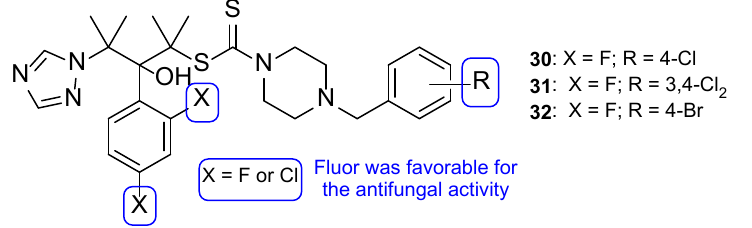
Figure 19. Chemical structures for compounds 30 – 32 and SAR for the phenyl ring [99]. In 2014, Wu et al. designed and synthesized a series of new fluconazole analogs, utilizing a thiazolidinedione scaffold instead of one of its triazole rings. The antifungal effects of the compounds were assessed using the broth microdilution method as values of MIC 80 and fluconazole was used as standard. Compounds 33 – 35 (Figure 20) presented good inhibitory activity against all tested strains ( C. albicans , C. parapsilosis , C. neoformans , C. glabrata , C. tropicalis , A. fumigatus , T. rubrum , and N. gypsea ) and demonstrating particularly high effect against C. albicans , with MIC 80 values of 0.030, 0.15, and 0.15 µ M, respectively (MIC 80 of fluconazole was 0.81 µ M). Additionally, 34 and 35 presented effective values against four fluconazole-resistant isolates of C. albicans , with MIC 80 values ranging approximately from 18.50 to 148.01 µ M for compound 34 and 37.00 to 74.00 µ